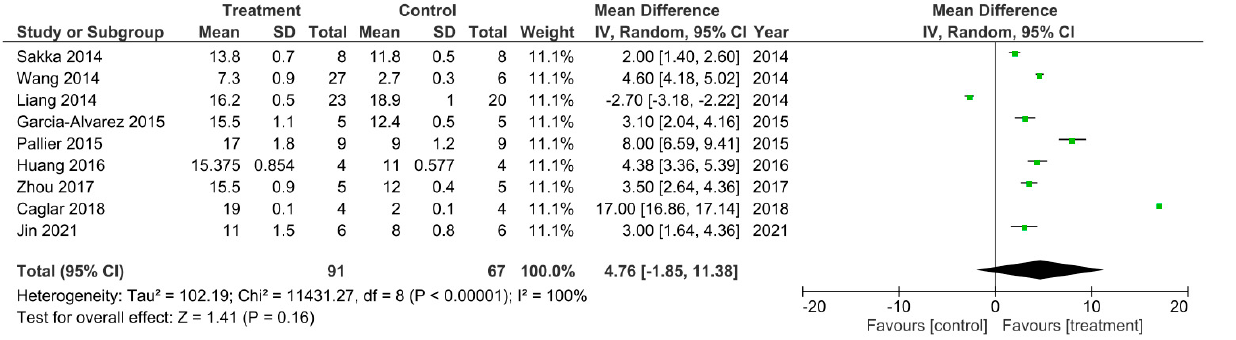
Figure 2. Meta-analysis for the effect of single treatments on the improvement of BBB scores analyzed at 28 days after spinal cord injury in nine studies [11,13,25,27,30,31,33,34,54].